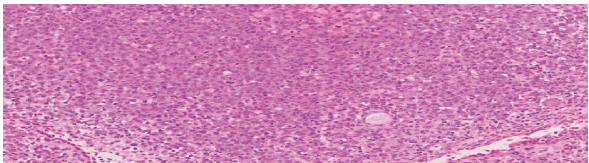
Figure 6: Microphotograph shows atypical large lymphoid cells with prominent 1-2 nucleoli, subendothelial infiltration, frequent mitoses, and a pseudorosette.